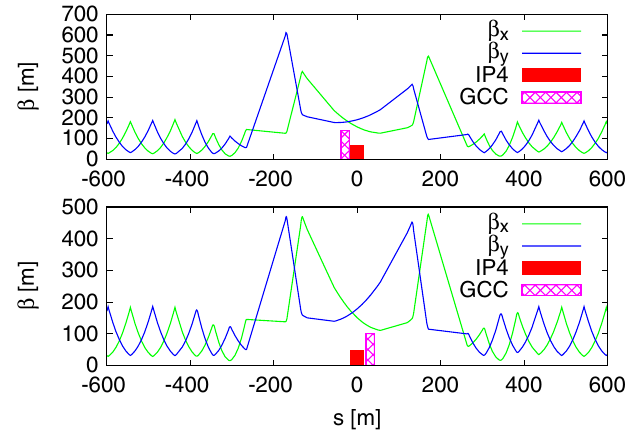
FIG. 4. (Color) Global crab optics at LHC IR4: nominal LHC collision optics (top) and lowbetamax collision optics (bottom). IP4 is at s ¼ 0 .